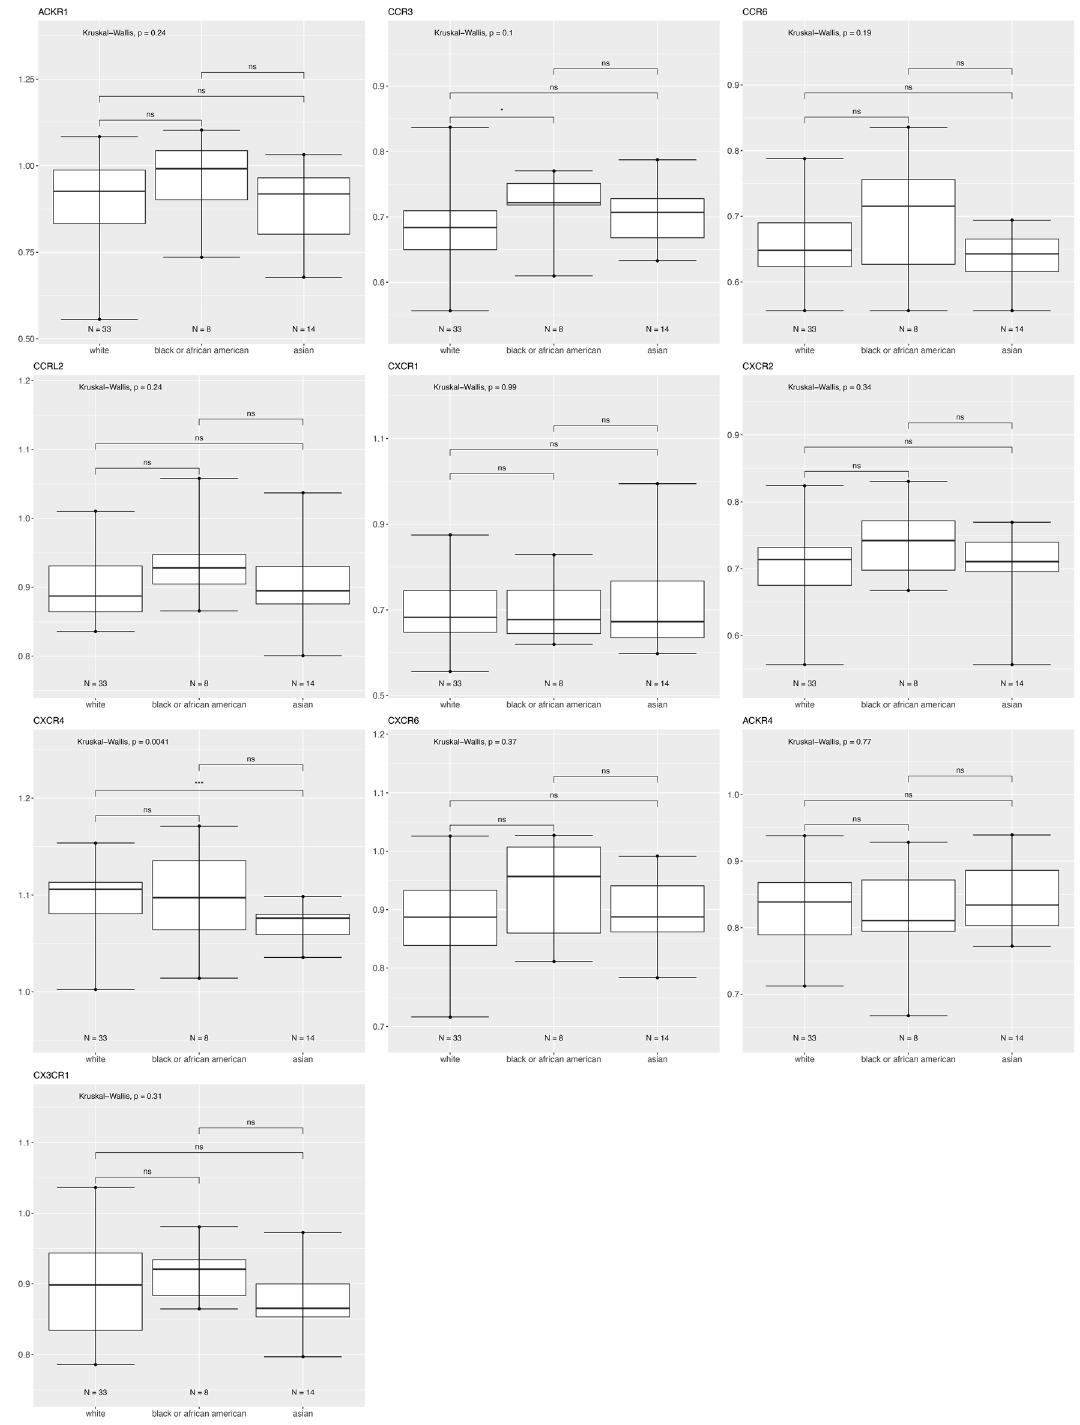
Figure 7. Differentially expressed chemokine receptor gene expression based on race within HER2 subtype using the breast cancer TCGA data for tumor samples only. Box and whisker plots represent minimum expression at the bottom whisker, maximum at the top whisker and median at the middle line with a Log10 axis scale showing gene expression of the chemokine receptors. Statistical significance was determined with global significance for ANOVA with Kruskal